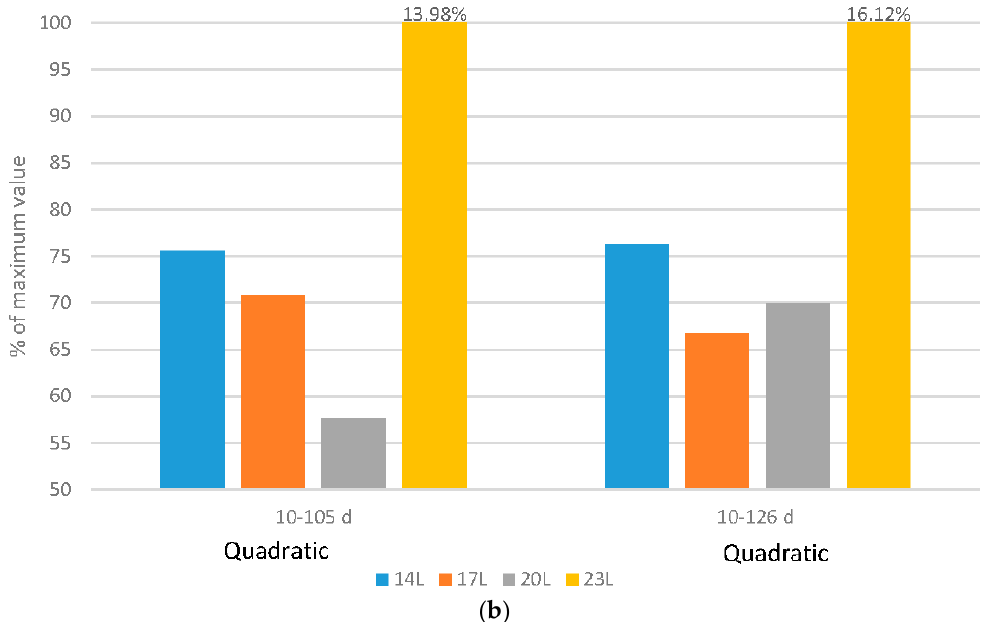
Figure 3. Impact of daylength on mortality and cull levels. ( a ) Comparison of broiler mortality and cull levels (% of placed) under four daylength photoperiods at three age ranges, with data expressed as a percentage of the maximum value within each age; ( b ) Comparison of turkey mortality and cull levels (% of placed) under four daylength photoperiods at two age ranges, with data expressed as a percentage of the maximum value within each age.